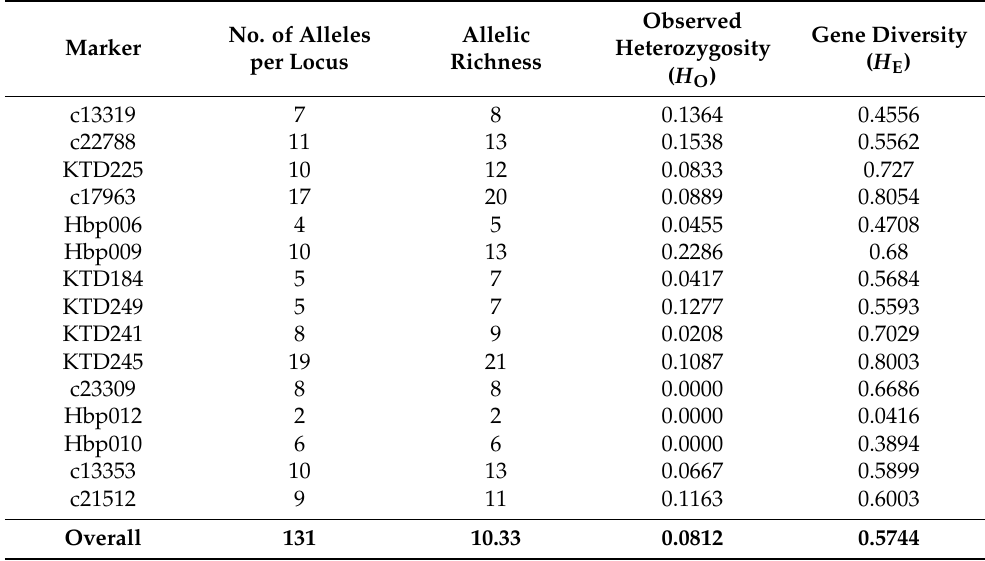
Table 6. Number of alleles per locus, observed heterozygosity, allelic richness, and gene diversity of core collection (47 accessions) of lablab. Observed Gene No. of Alleles Allelic Heterozygosity Marker per Locus Richness ( H O )